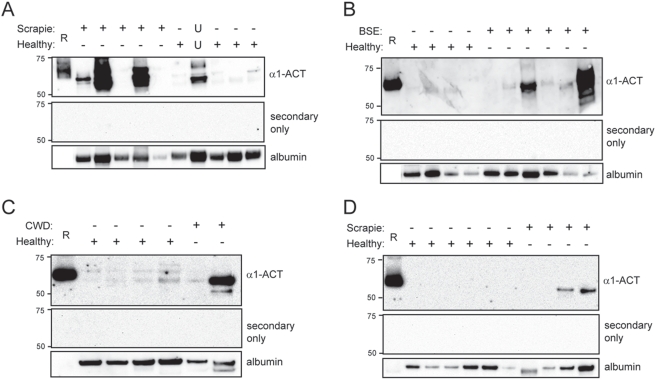
Western blot analysis of urinary α1-ACT from natural field cases of prion disease.Equivalent amounts of urinary protein from natural terminal field cases of (A) sheep scrapie (65 µg), (B) cattle BSE (30 µg), (C) deer CWD (90 µg) and (D) pre-mortem sheep scrapie (65 µg), together with urinary protein from appropriate healthy controls, were fractionated under reducing SDS-PAGE conditions and subsequently analyzed by Western blot using an anti-human α1-ACT monoclonal (A, B & D) or polyclonal (B) antibody. In each case a duplicate blot incubated with HRP-labeled secondary antibody alone was also prepared and is shown. To verify equivalent protein loading, blots were stripped and re-probed with an anti-human albumin antibody. Recombinant α1-ACT (30 ng) was loaded as positive control. Molecular weight marker positions are indicated. Panel A, lane 8 represents urine from a suspected scrapie case, the precise status of which is unclear (U) at present. Pre-terminal sheep scrapie urine (D) was analyzed from six individual healthy sheep and from one case at 10, 9, 2 & 1 months prior to being sacrificed at end-stage of disease (lanes 8–11 respectively).